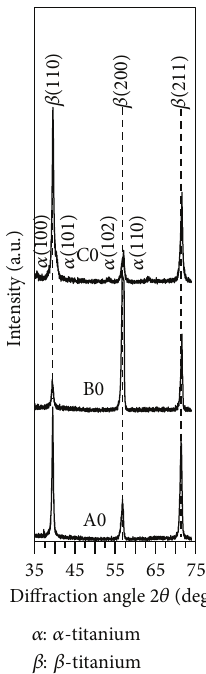
Figure 5: The respective XRD pattern for A0, B0, and C0 sheets.